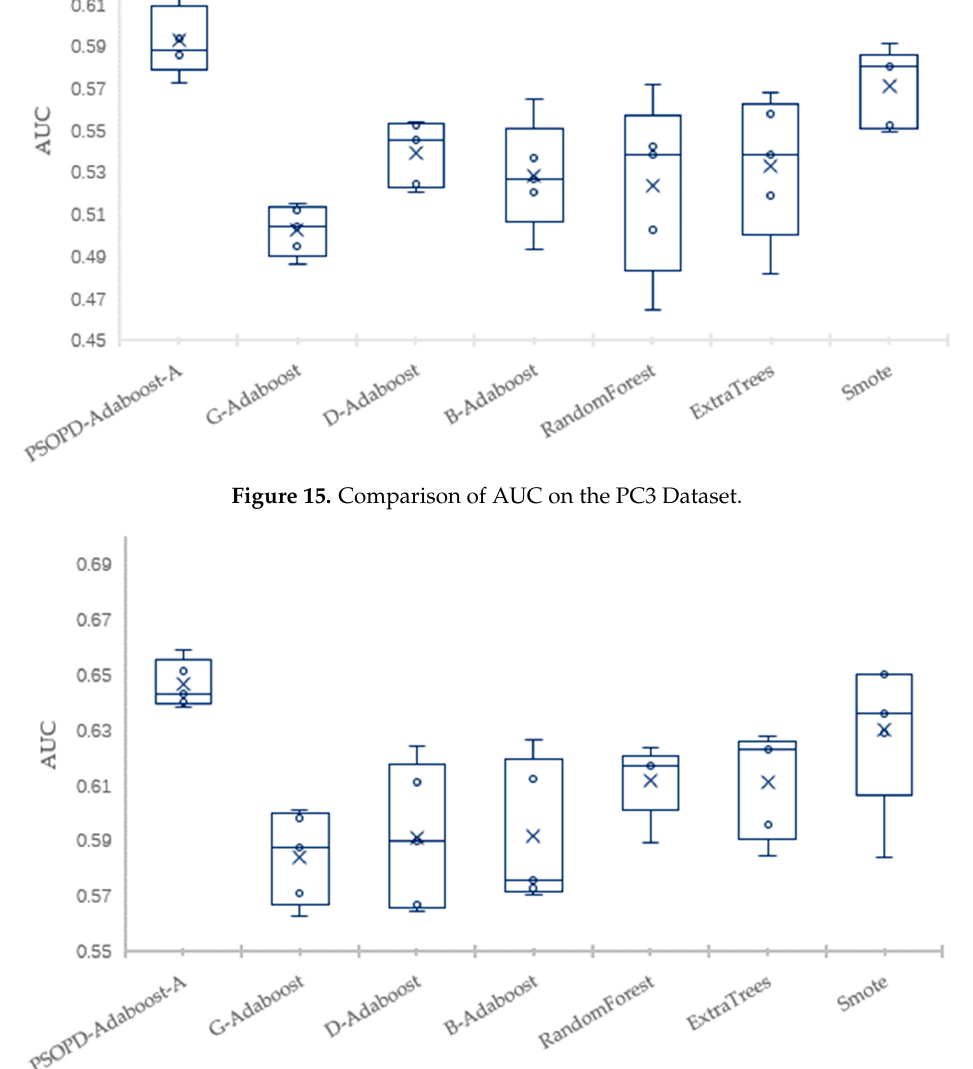
Table 5. Comparison of Classification Results on the PC5 Dataset.